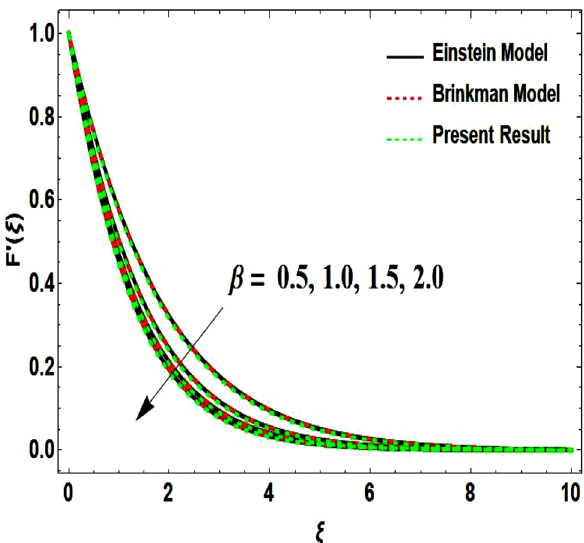
Figure 11. Velocity curve influenced by velocity power index